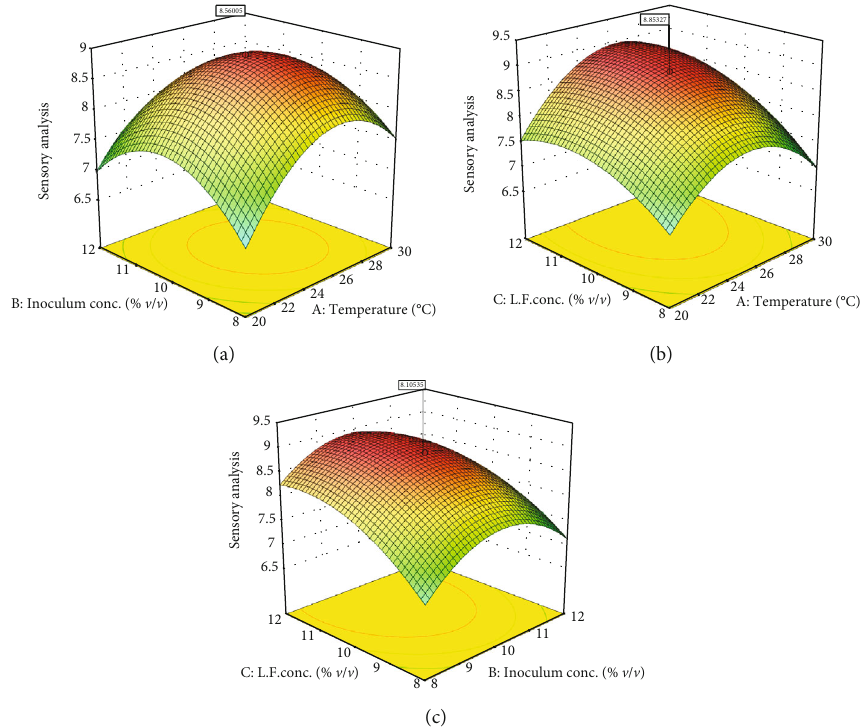
Figure 3: Response surface and contour plots for the e ff ect of inoculum concentration (a, Lantana camarafruit concentration = 10 %v / v ) and temperature; Lantana camara fruit concentration (b, inoculum concentration = 10 %v / v ) and temperature; Lantana camara fruit concentration (c, temperature = 25 ° C ) and inoculum concentration on the sensory value of the produced